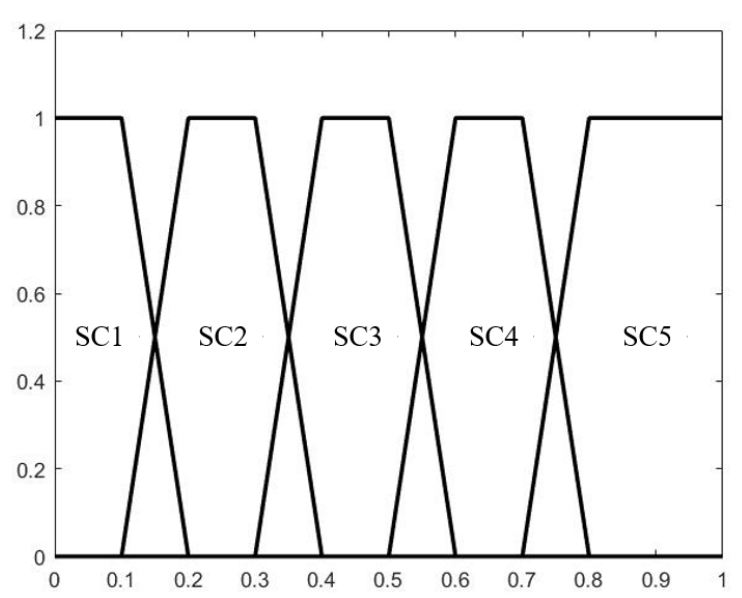
Figure 3. The membership of the capability layer.